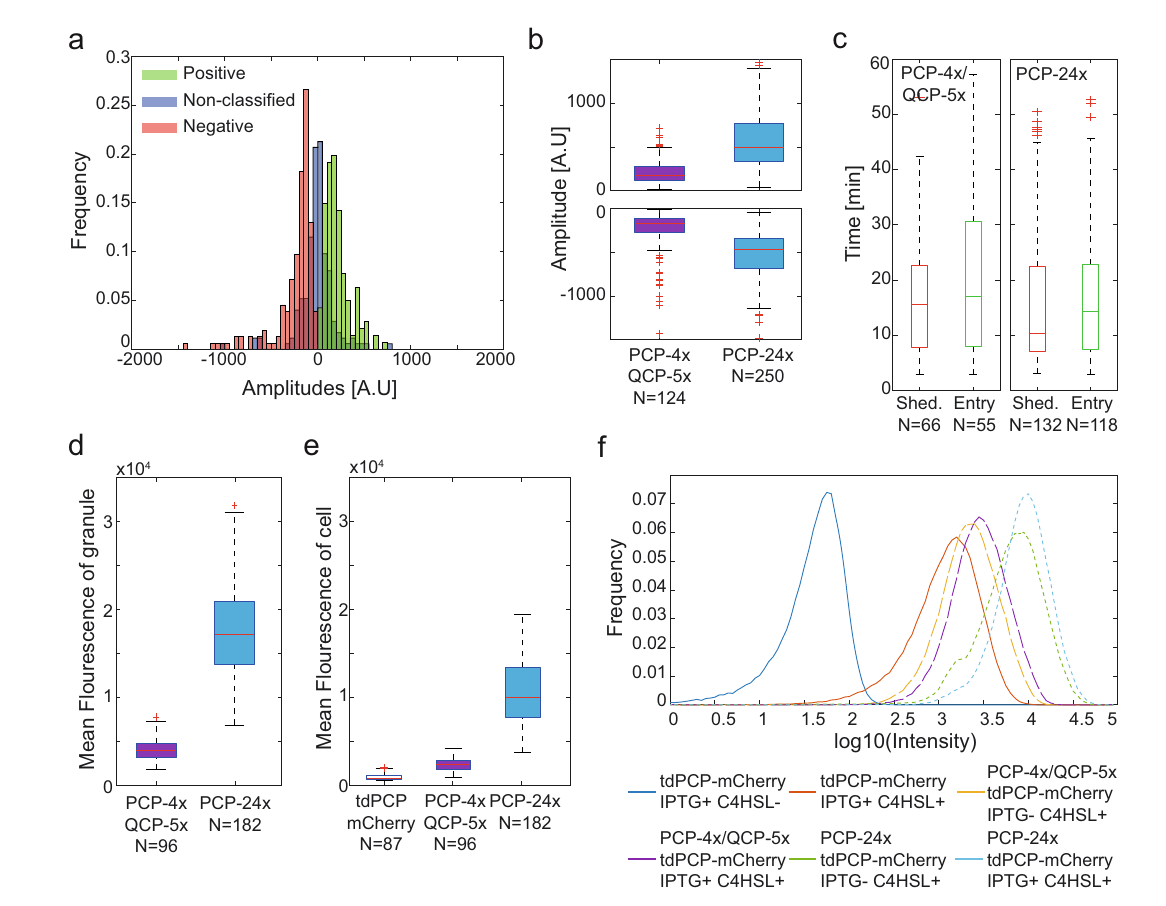
Fig. 7 | In vivo granules present similar dynamics as in vitro. a Empirical amplitude distributions gathered from 255 traces in vivo from cells expressing the PCP-4x/QCP-5x slncRNA together with the tdPCP-mCherry protein. b Boxplots depicting burst amplitude distributions (top — positive bursts, bottom — negative bursts). c Boxplots depicting distributions of durations between entry events (green), and durations between shedding events (red). d Boxplot of mean granule fl uorescence intensity. e Boxplot of mean cell fl uorescence intensity. In ( b – e ) On